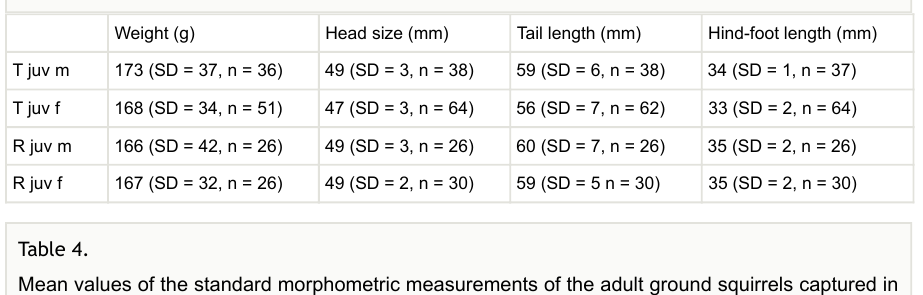
Mean values of the standard morphometric measurements of the resident juveniles captured in Momina tsarkva (R) between 21.06 and 19.07 of each year (2017-2019) and the juveniles from Topolchane (T), translocated in the same period. n = sample size, SD = standard deviation